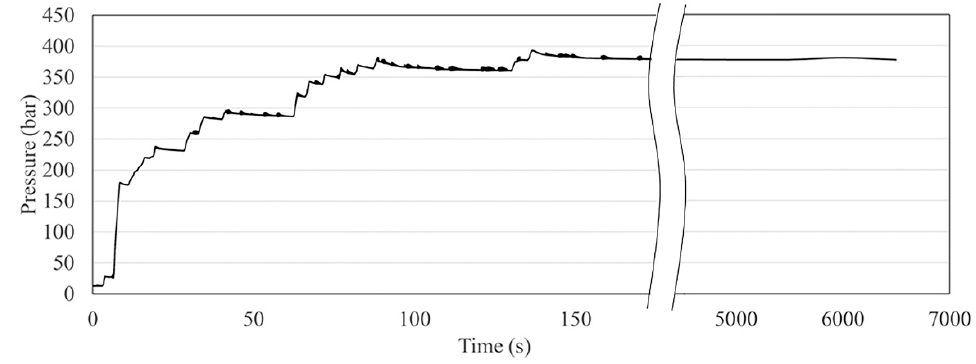
Figure 6. Pressure testing of FSC sample.